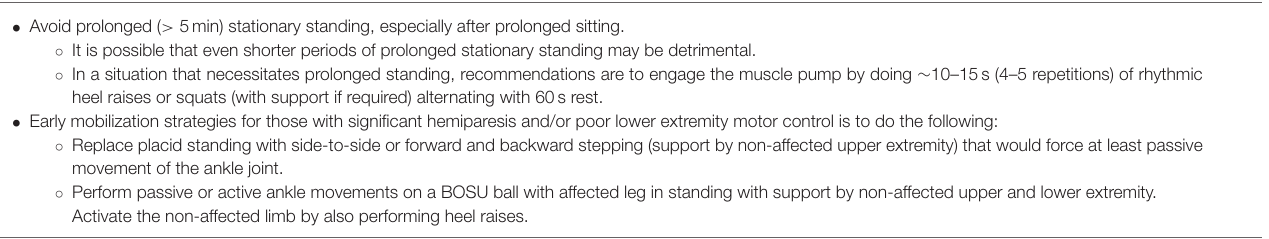
TABLE 5 | Guideline 4.0: Precautions for preventing adverse effects from prolonged